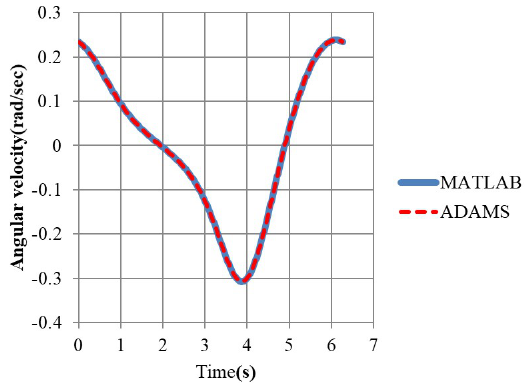
Figure 8. Comparison of our modeling computation with that of ADAMS on ω 5 Figure 8. C omparison of our modeling computation with that of ADAMS on 5  .